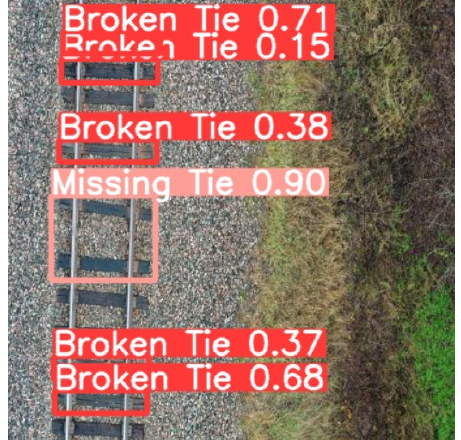
Figure 20. Positive broken tie detection.